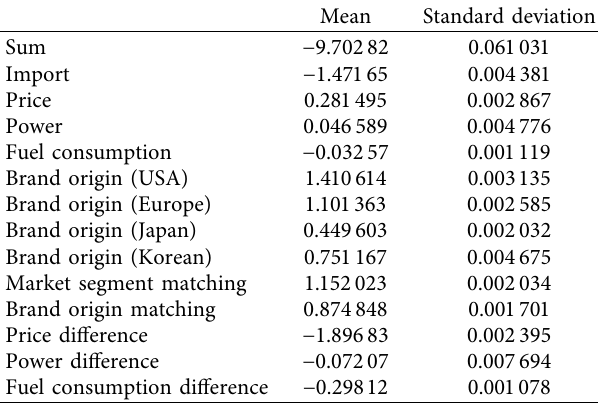
Table 3: With 50 different samples of 50,000 customers, the mean and standard deviations of estimated parameters show the model is stable and